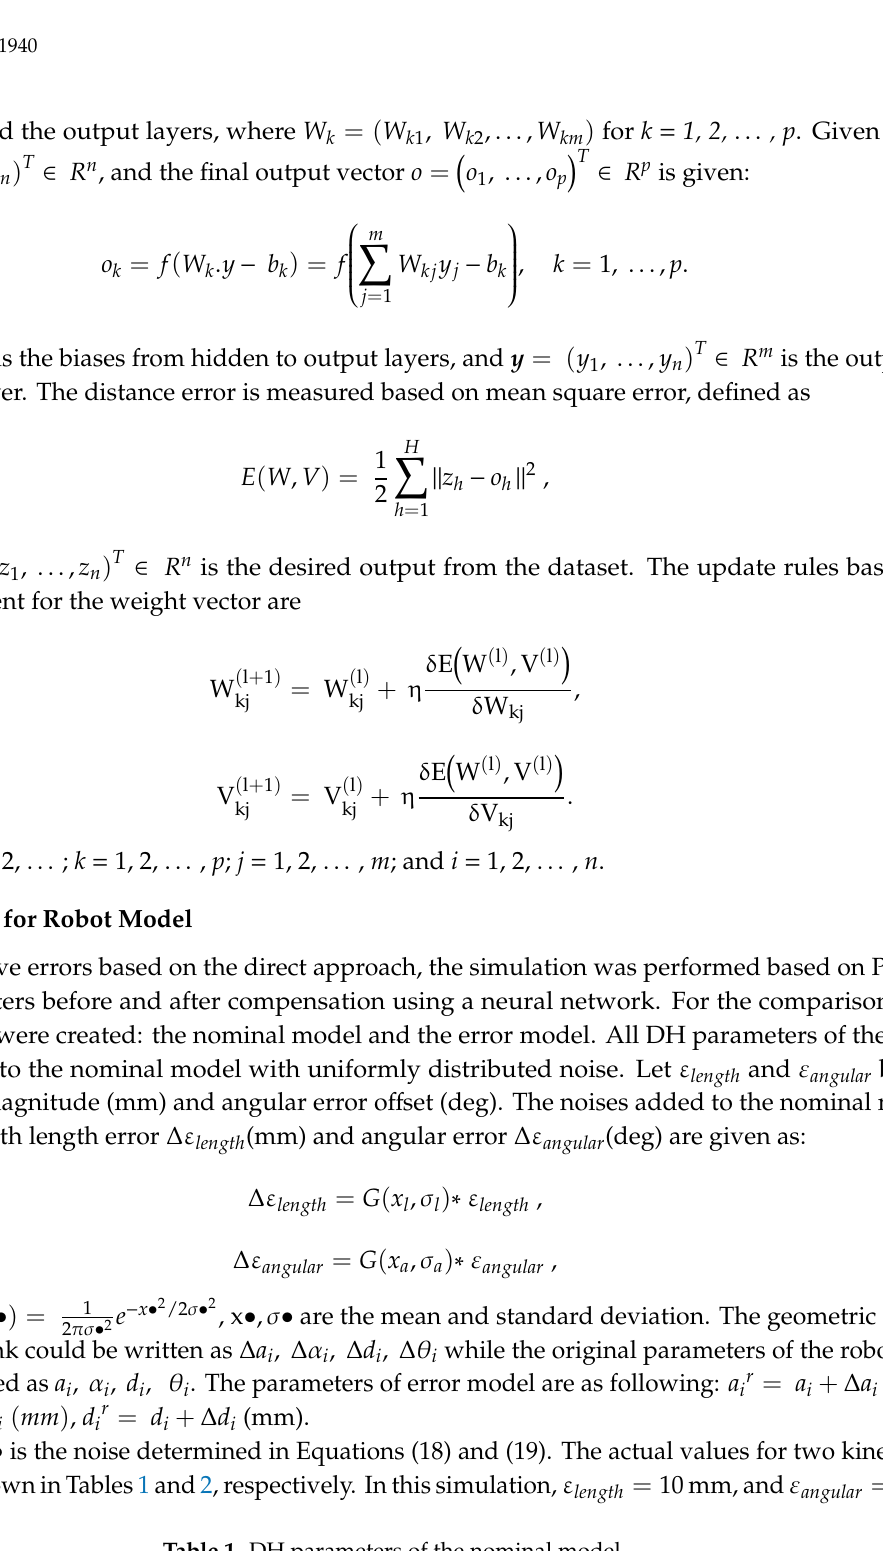
Table 1. DH parameters of the nominal